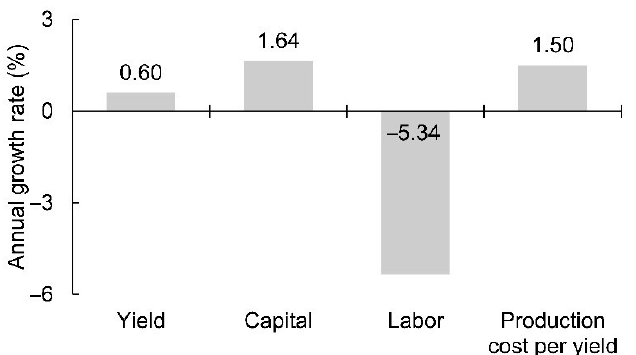
Figure 2. Annual growth rate of yield, capital input, labor input, and production cost per yield in rice production in China, 2000–2020. Data from the State Development Planning Commission of China [24], and National Development and Reform Commission of China [25].